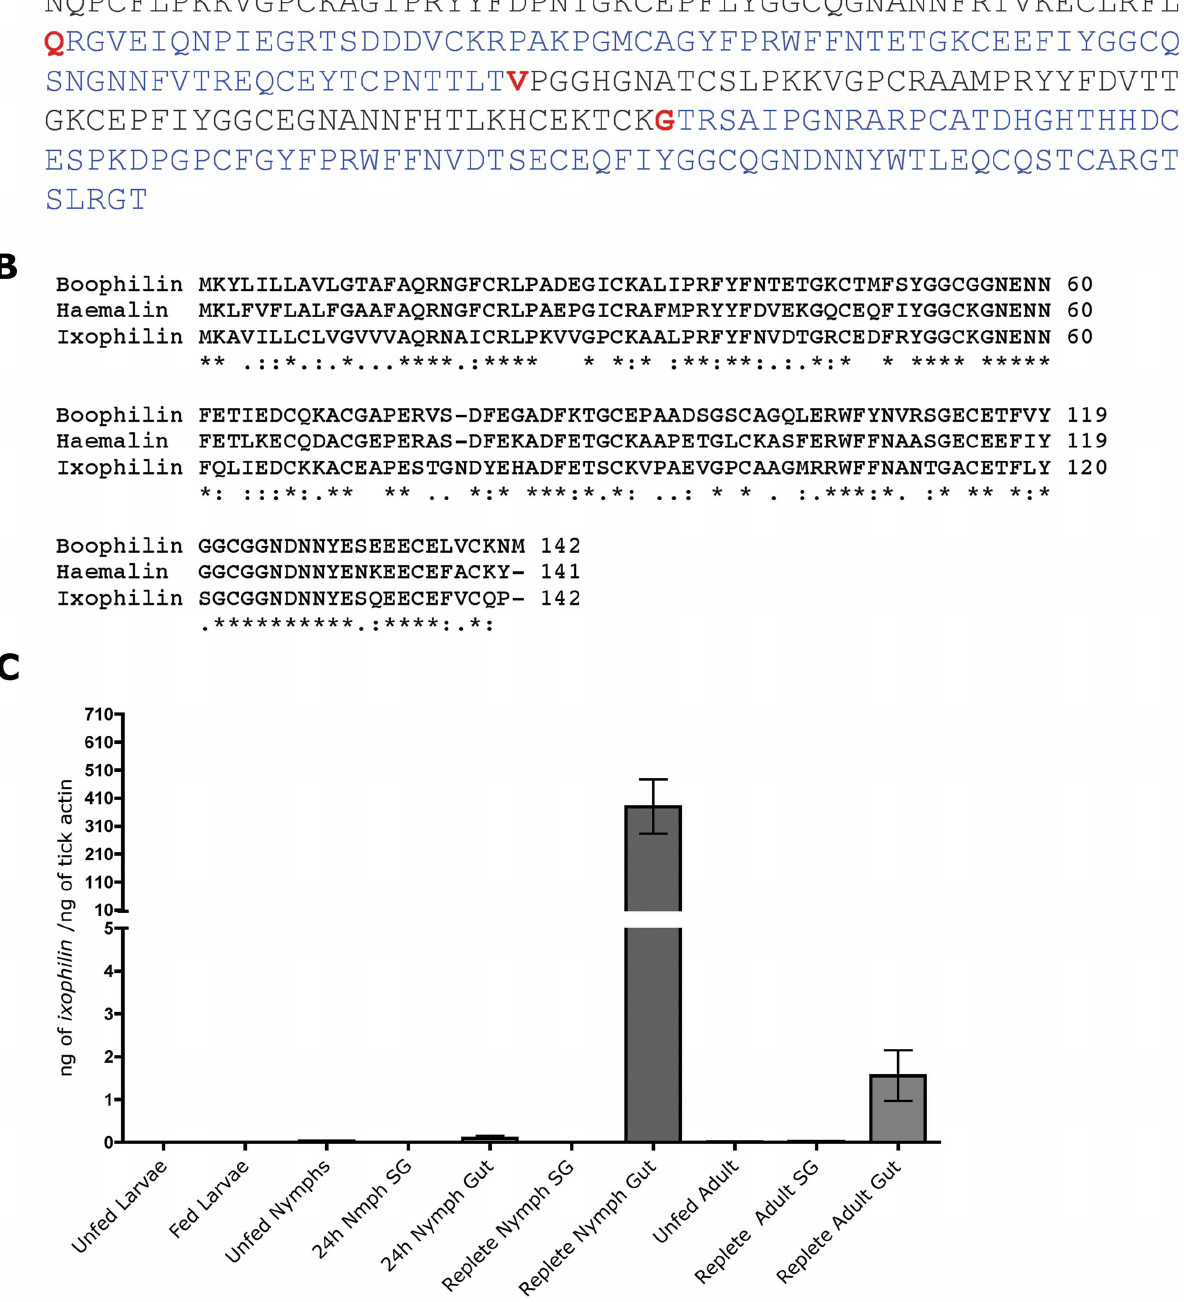
Figure 3. Ixophilin shows homology with thrombin inhibitors, and is preferentially expressed in the guts of nymphal and adult Ixodesscapularis . A. Annotated sequence of protein encoded by ISCW003862 (Ixophilin). Alternating colors indicate exons, aminoacids underlined in red indicate the end of each exon. Arrow-head indicates the signal cleavage site between Alanine and Glutamine. B. ClustalW alignment of Ixophilin, Boophilin [17] and Hemalin [16]. Asterisks (*) indicate identity between all three sequences; colon (:) indicates conservation between groups